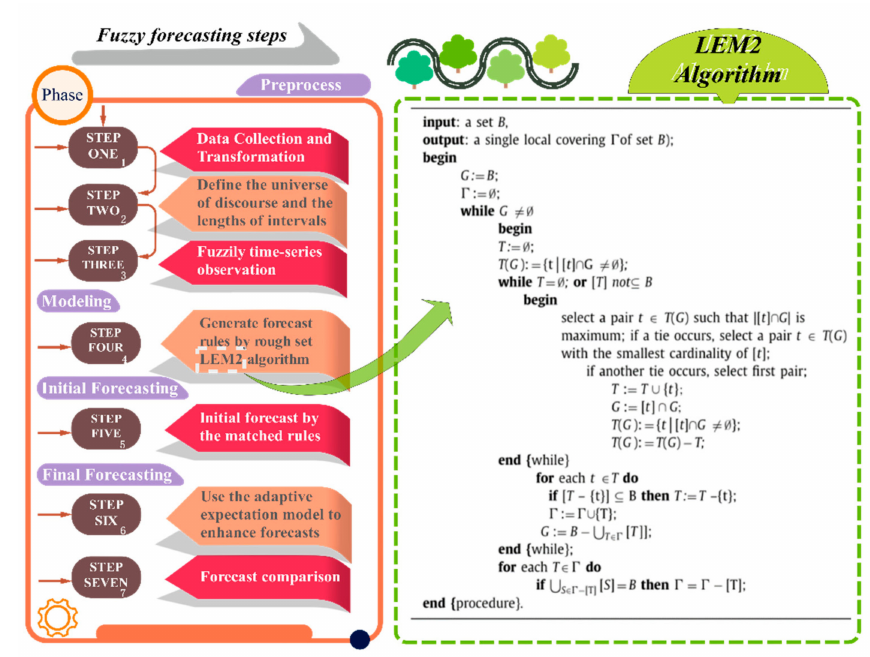
Figure 3. Flowchart of fuzzy time series